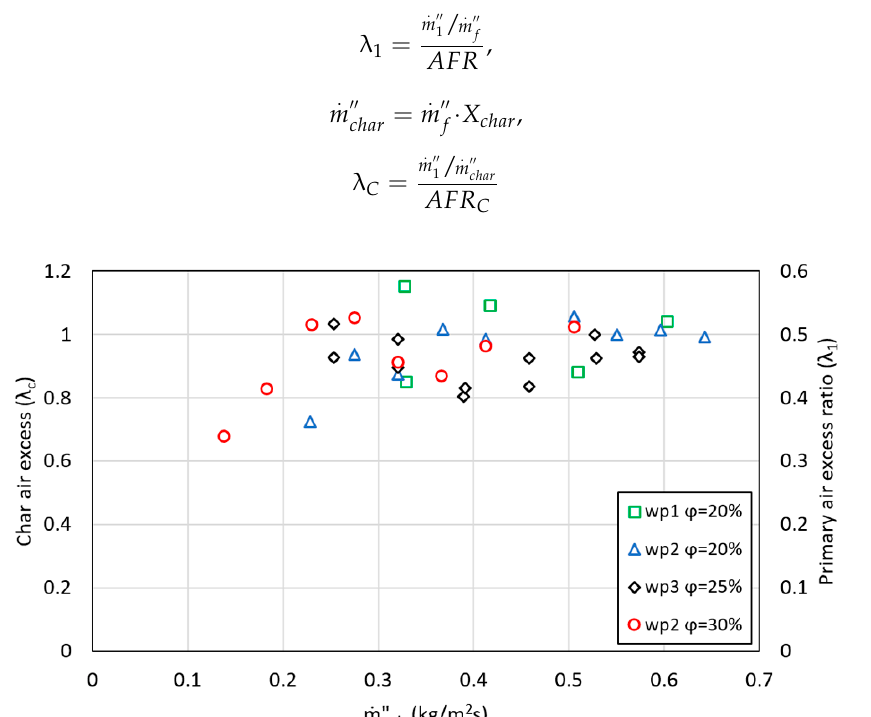
Figure 7. Primary ( λ 1 ) and char ( λ C ) excess ratios versus total airflow rate.